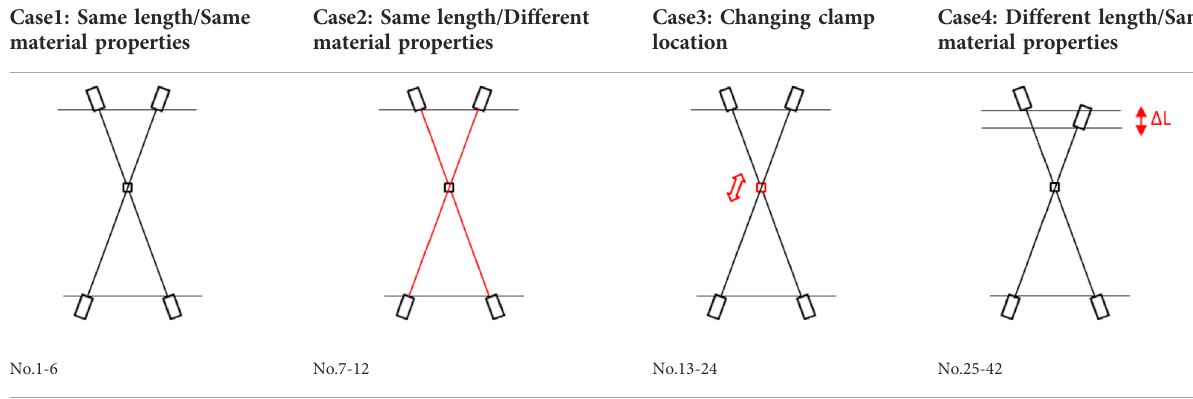
TABLE 1 Four numerical veri fi cation cases.